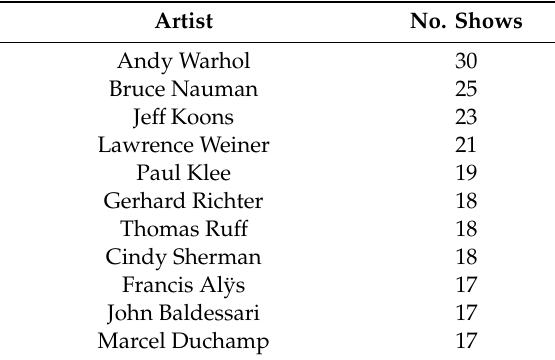
Table 7. Most-exhibited artists.